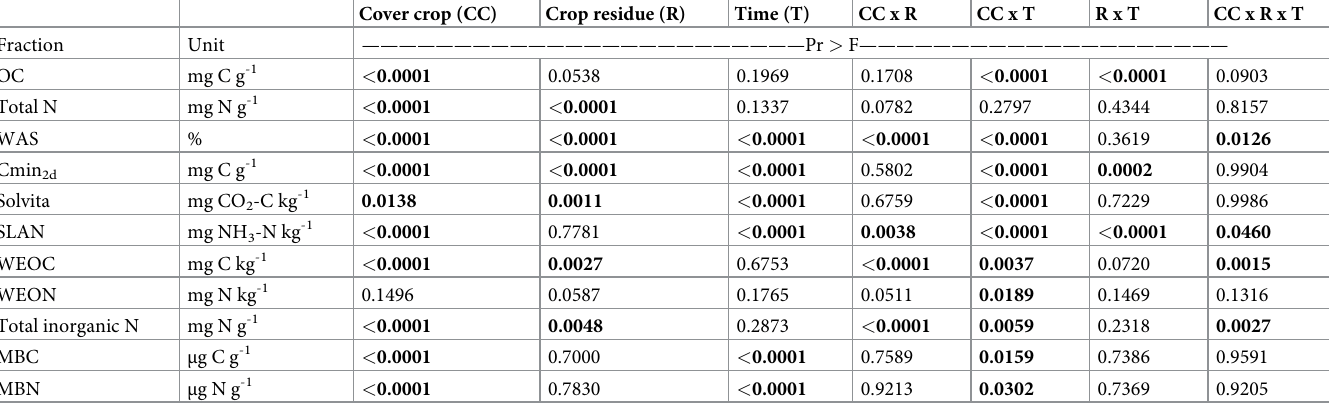
Table 3. Probability values for the main effects of medium-term summer-planted cover crop (6-yrs), crop residue management, sampling time, and interactions on soil stable and labile fractions of C and N sampled from 0–15 cm depth in site-year 2015.